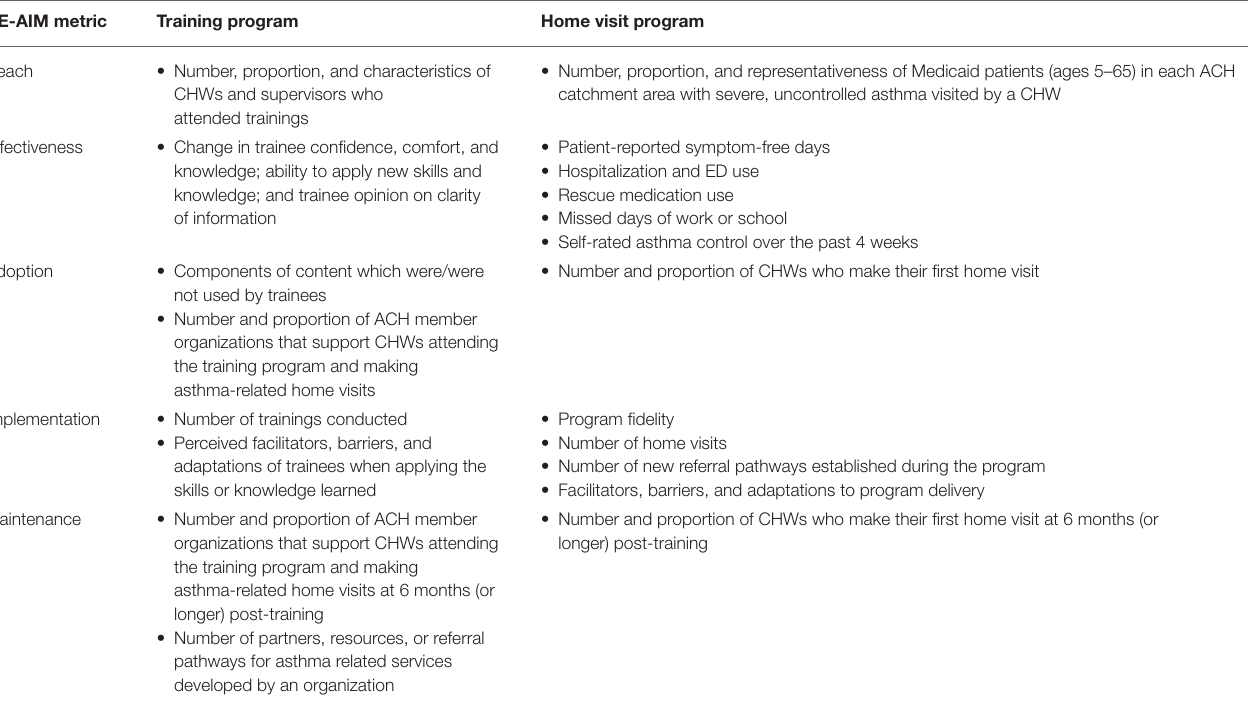
TABLE 3 | Evaluation